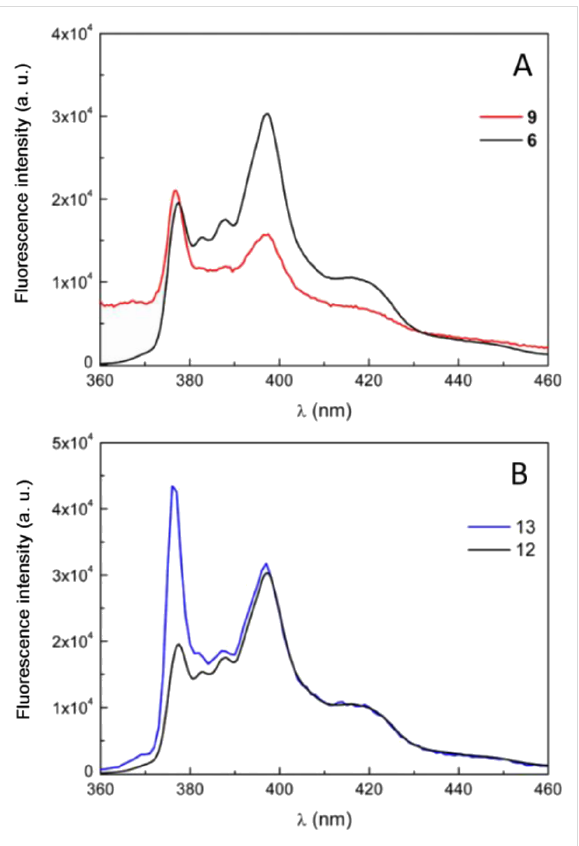
Figure 3: A) Fluorescence spectra of 6 (black curve) and 9 (red curve). B) Fluorescence spectra of 12 (black curve) and 13 (blue